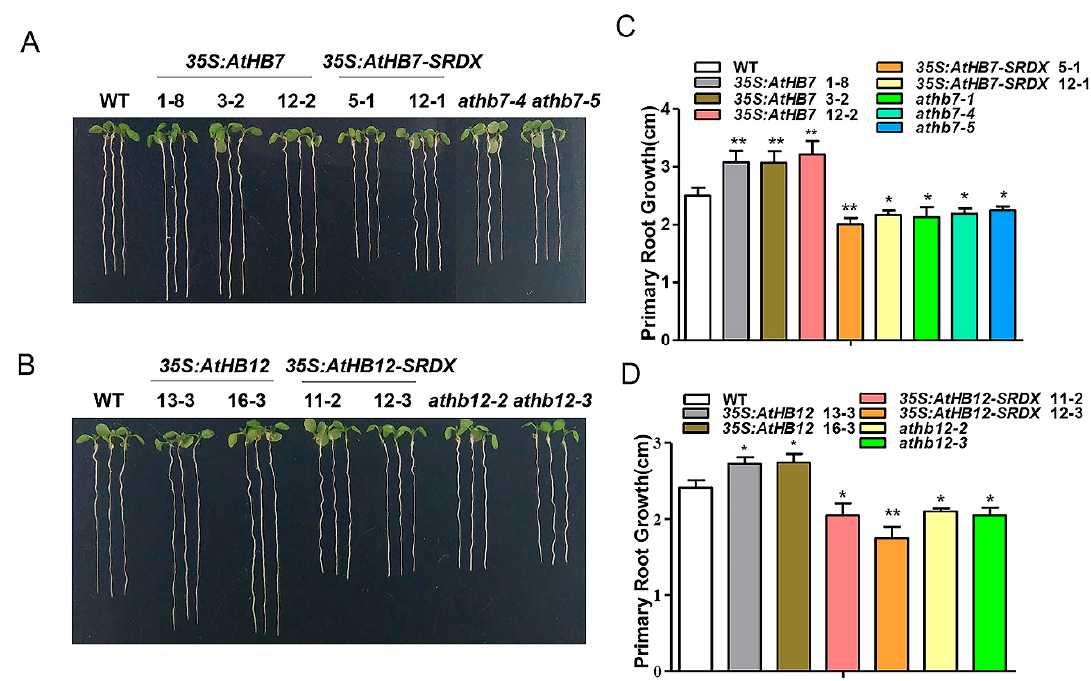
Figure 3. AtHB7 and AtHB12 contribute to primary root growth during normal development. Phenotype of 6-day-old AtHB7 ( A ) and AtHB12 ( B ) overexpression lines, SRDX (SUPERMAN repression domain) transgenic seedlings and mutants under standard growth condition. Primary root length in A ( C ) and B ( D ). Data are means ± SD ( n = 24). Asterisks indicate significant differences between wild type and transgenic lines at *: p < 0.05 and **: p < 0.01 by Tukey’s test.